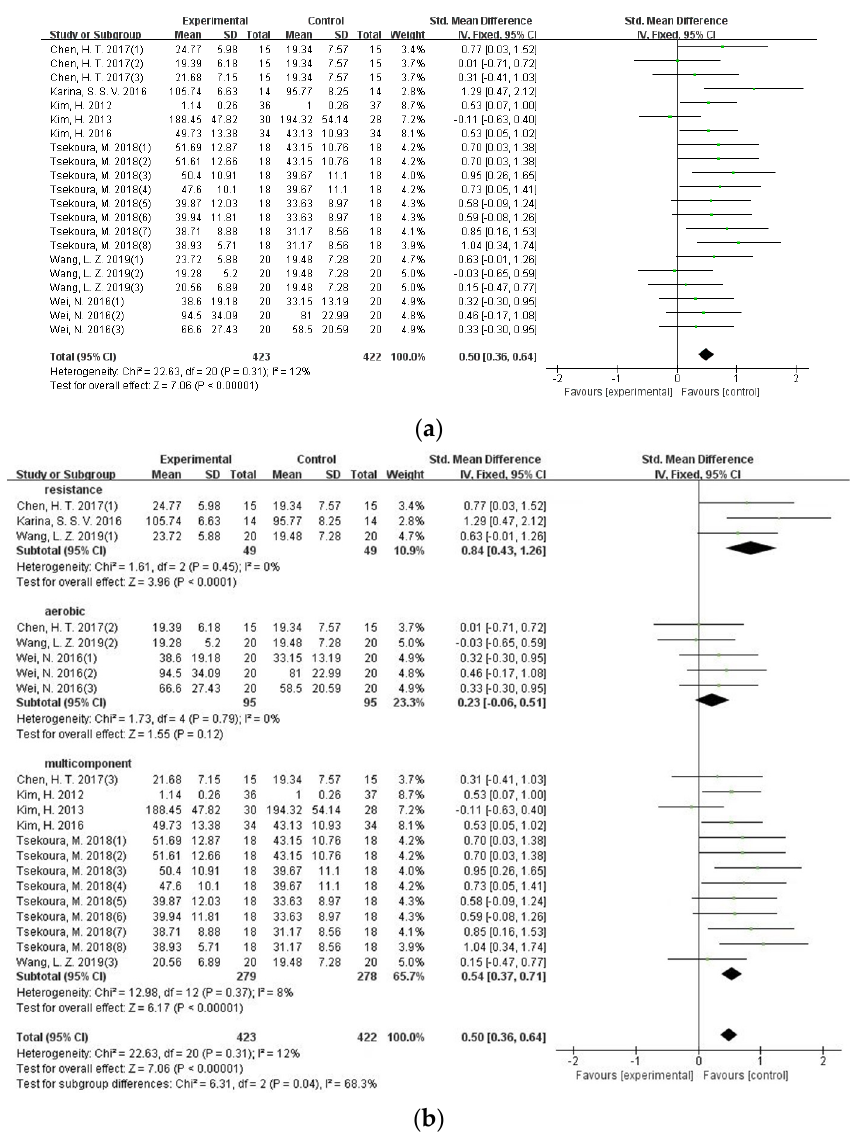
Figure 4. ( a ) Forest plot of the effectiveness of exercise interventions for knee extension strength improvement in older adults with sarcopenia; ( b ) forest plot of the effectiveness of exercise interventions for knee extension strength improvement according to different exercise types.